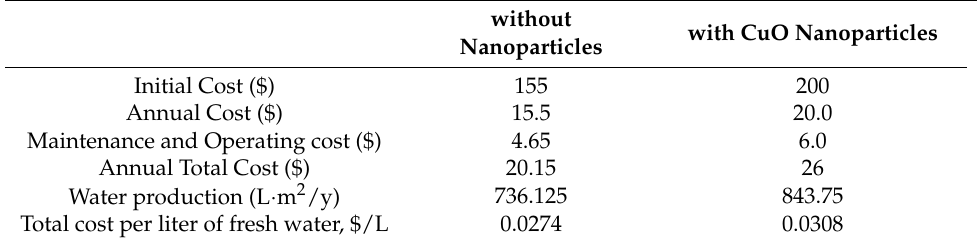
Table 2. Economic analysis of the proposed desalination system.